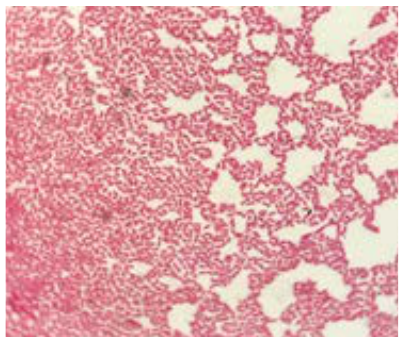
fIgURE 3 – Microscopy (Gram): pink coccobacilli